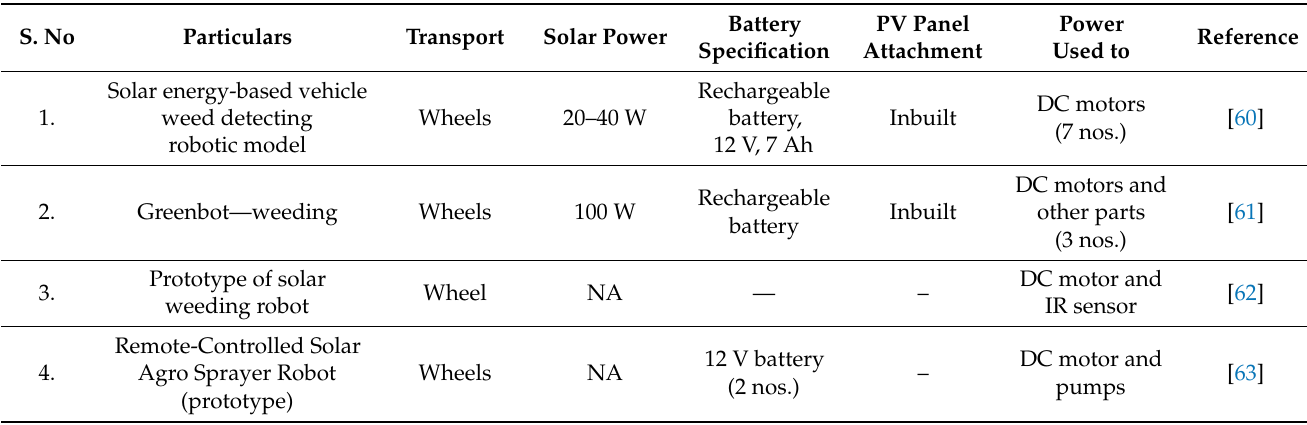
Table 1. Different types of powered weeders.